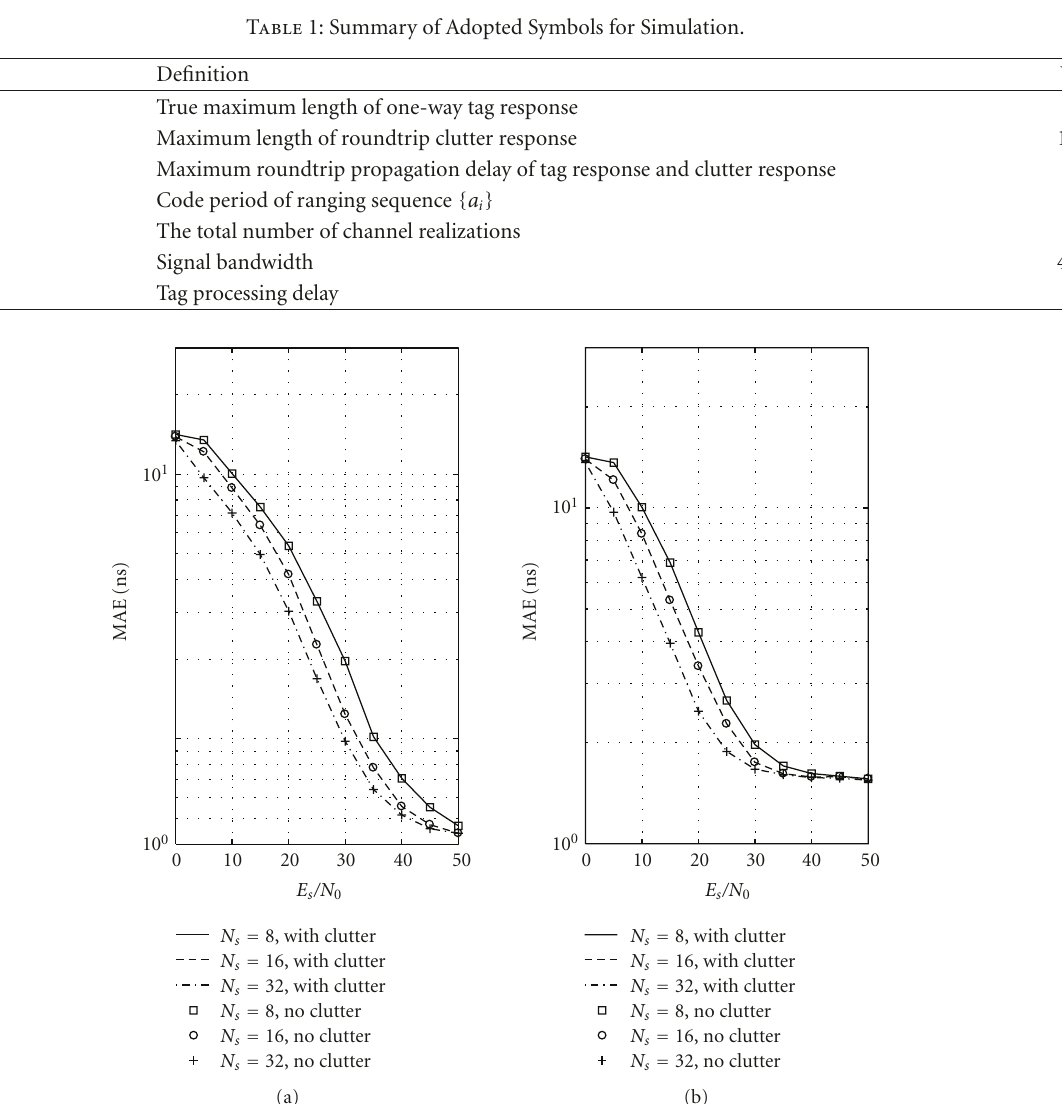
Figure 3: Performance comparison of the estimator under the scenarios with and without clutter for di ff erent number of sampled symbols in CM1 (a) and CM2 (b) with T ds = 45ns, f s = 8 GHz, N f = 4, and SCR = −